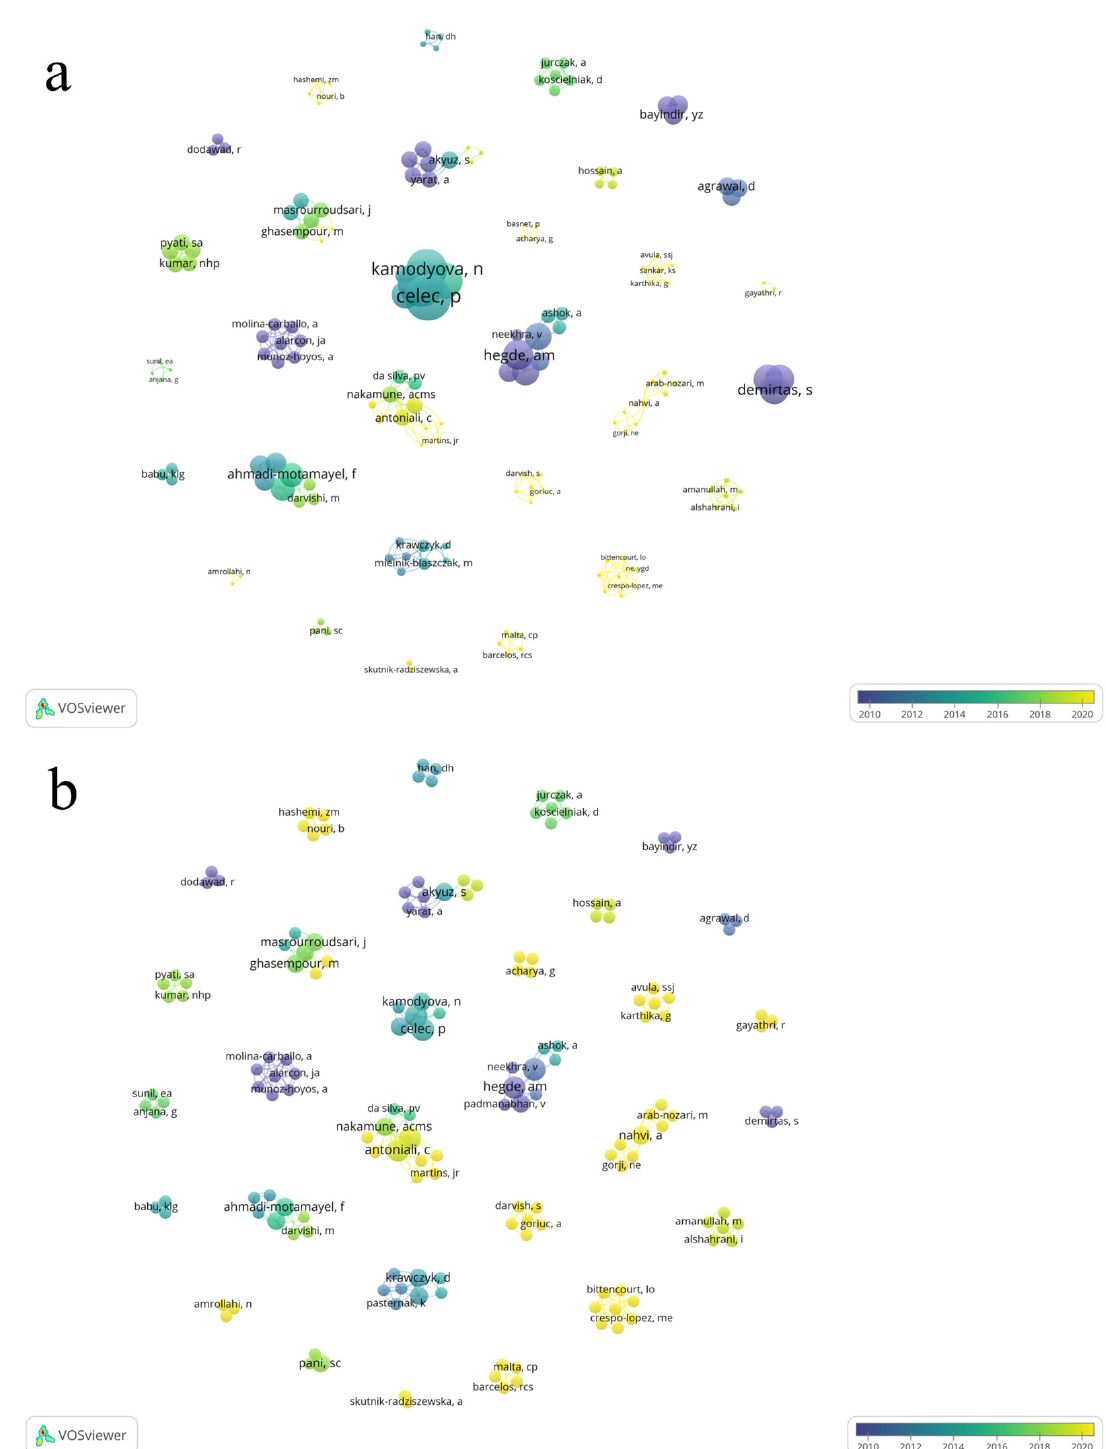
Figure 3. Co-authorship overlay visualization of the 43 articles showing the collaboration of the authors of the selected articles about the relation of dental caries and salivary oxidative stress. The total of 164 author form 30 clusters. The overlay visualization, the lines connecting authors the size of node denote number of articles ( a ) and number of citations ( b ),